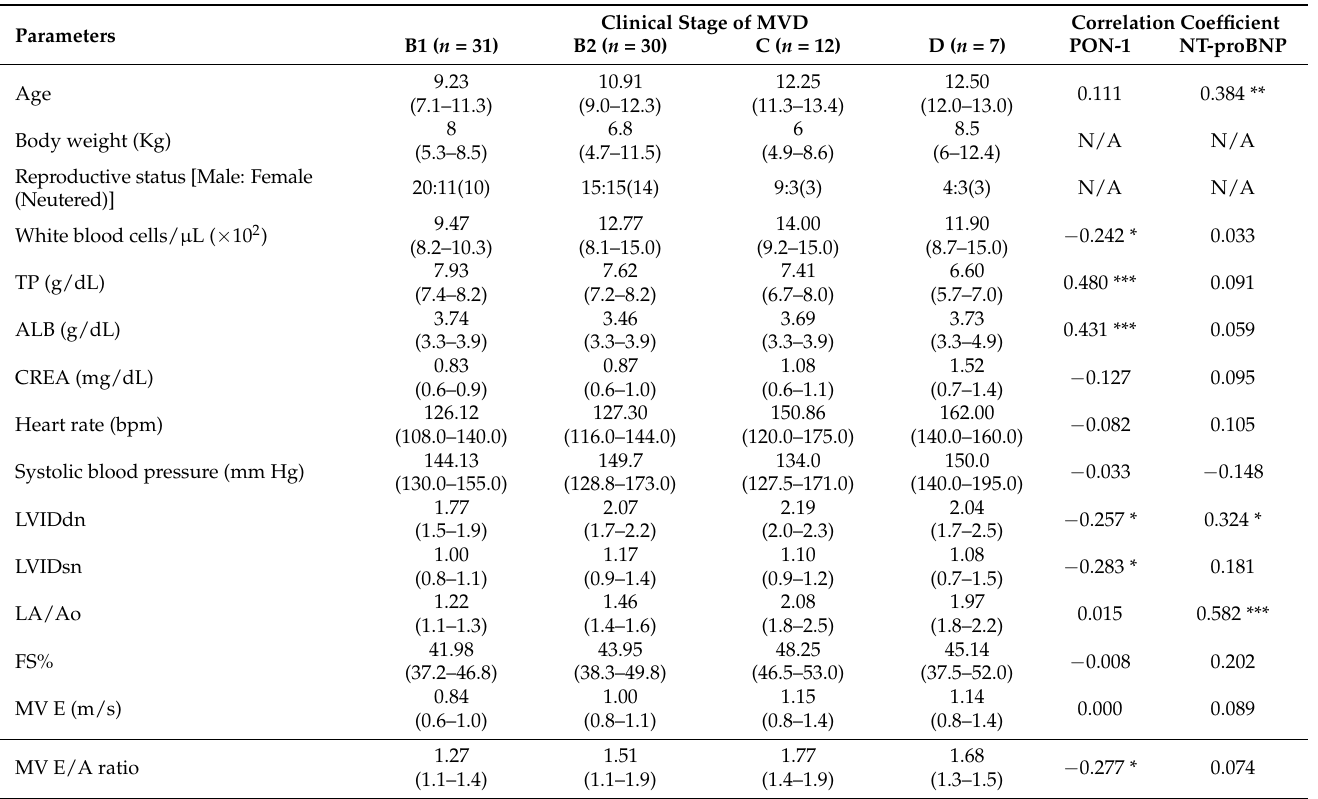
Table 1. Basic descriptive statistics (in terms of mean and interquartile range) within the clinical stage of MVD and correlation analysis with PON-1 and NT-proBNP of various clinical, clinico- pathological, and echocardiographic parameters. (MVD: Mitral Valve Disease; PON-1: Paraoxonase-1; NT-proBNP: N-terminal-prohormone-B-type natriuretic peptide; N/A: not applicable; TP: Total proteins; ALB: Albumin; CREA: Creatinine; LVIDdn: Left ventricular internal diameter at diastole normalized;LVIDsn: Left ventricular internal diameter at systole normalized; LA/Ao: Left atrial to aortic root ratio; FS%: Fractional shortening; MV E: Mitral valve E wave velocity; MV E/A ratio: Mitral valve E wave to A wave velocity